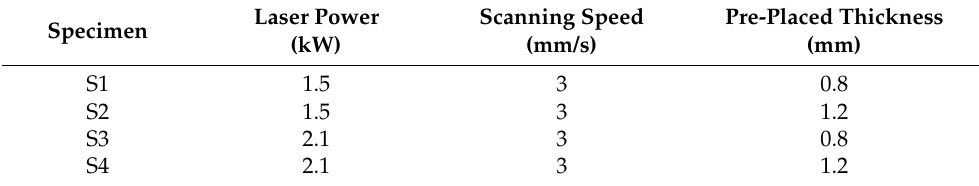
Table 6. Different specimens for analysis of microstructure and properties.